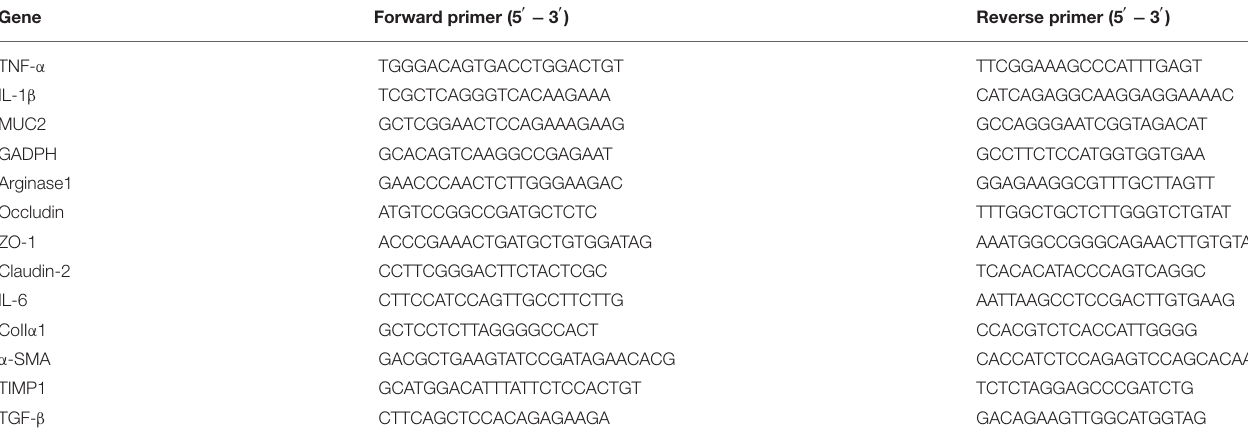
TABLE 1 | The list of reverse transcription quantitative real-time PCR (RT-qPCR) primers for mice. Gene